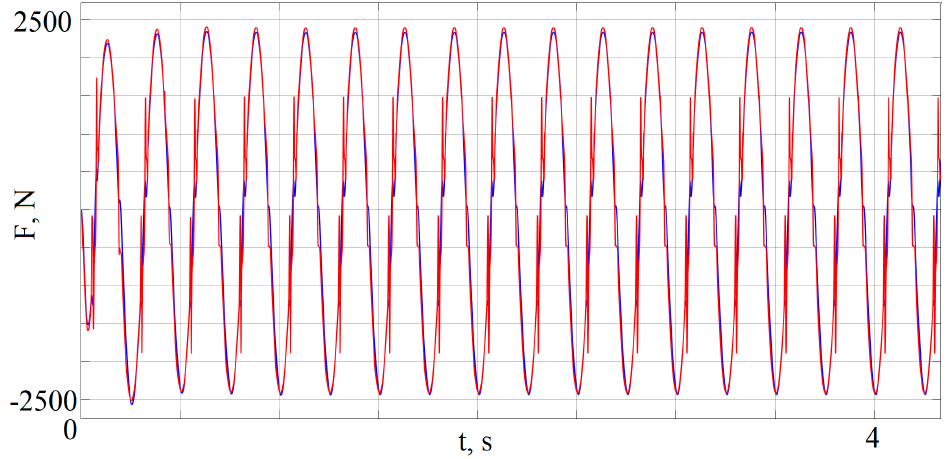
Figure 19. Desired force on the rod generated by the high level PID controller in the case of a sine excitation (blue) and actual force on the rod (red).